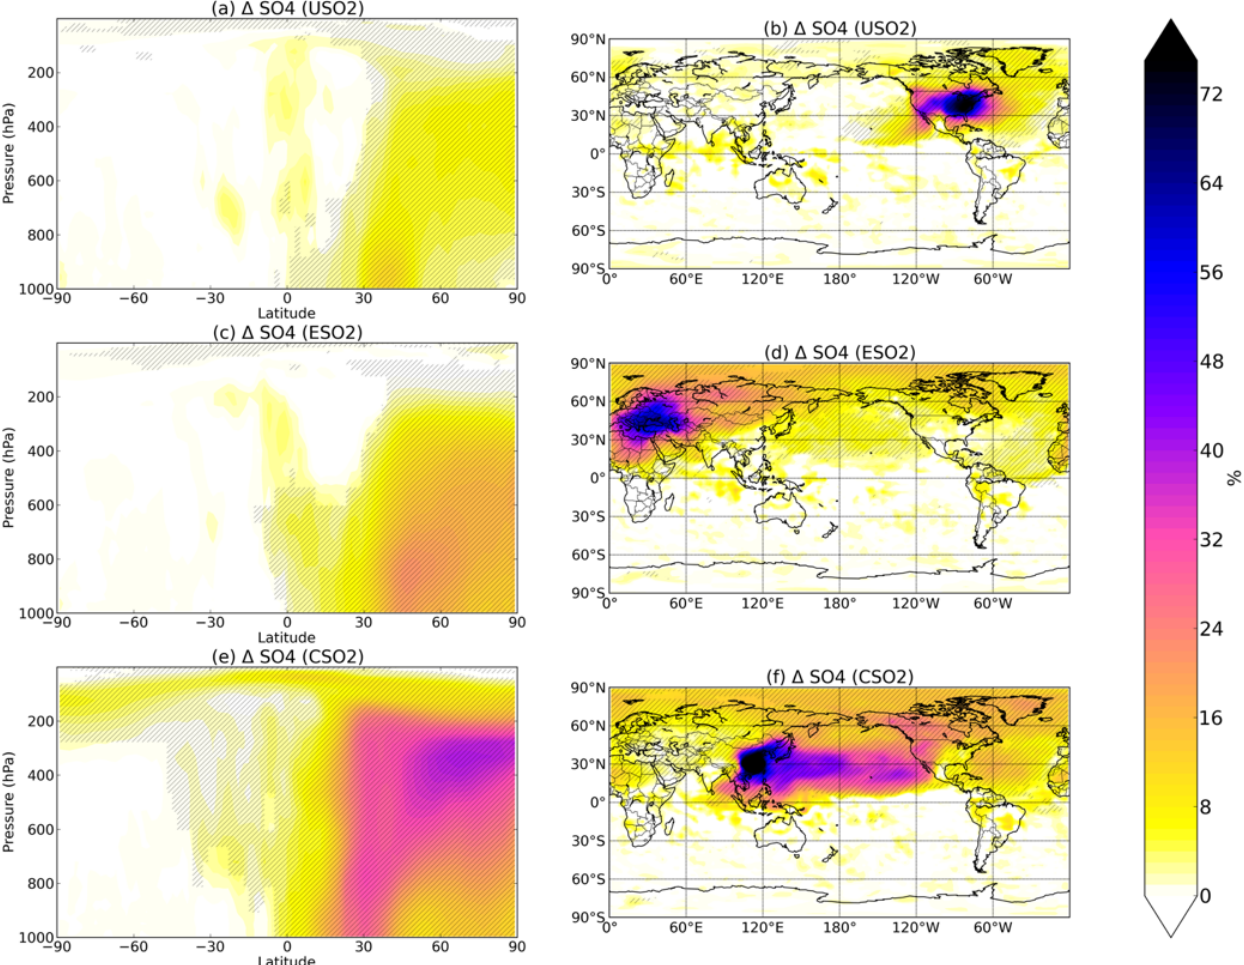
Figure 1. Boreal springtime (MAM) mean percent change in sulfate concentration between a control simulation and a perturbation simulation in which anthropogenic SO 2 emissions are removed over a certain region: (a, b) US, (c, d) Europe, and (e, f) China. Hatching denotes statistical significance according to a Student’s t test at the 95% confidence level.